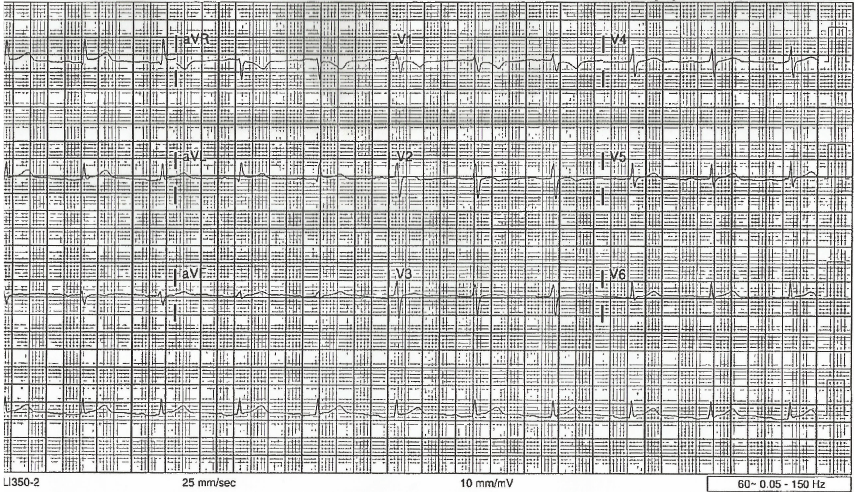
Figure 5: The ECG shows normal sinus rhythm. ECG recording speed of 25